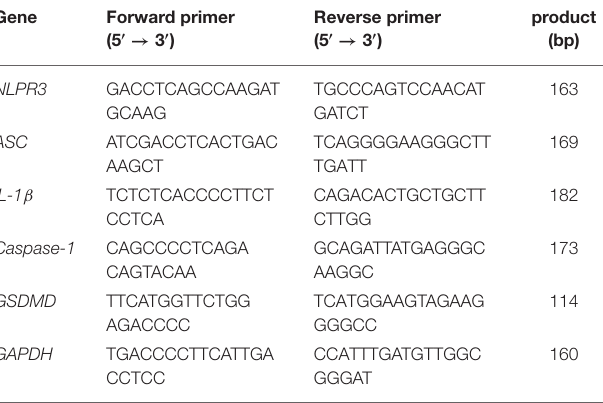
TABLE 1 | Primer sequences for qRT-PCR